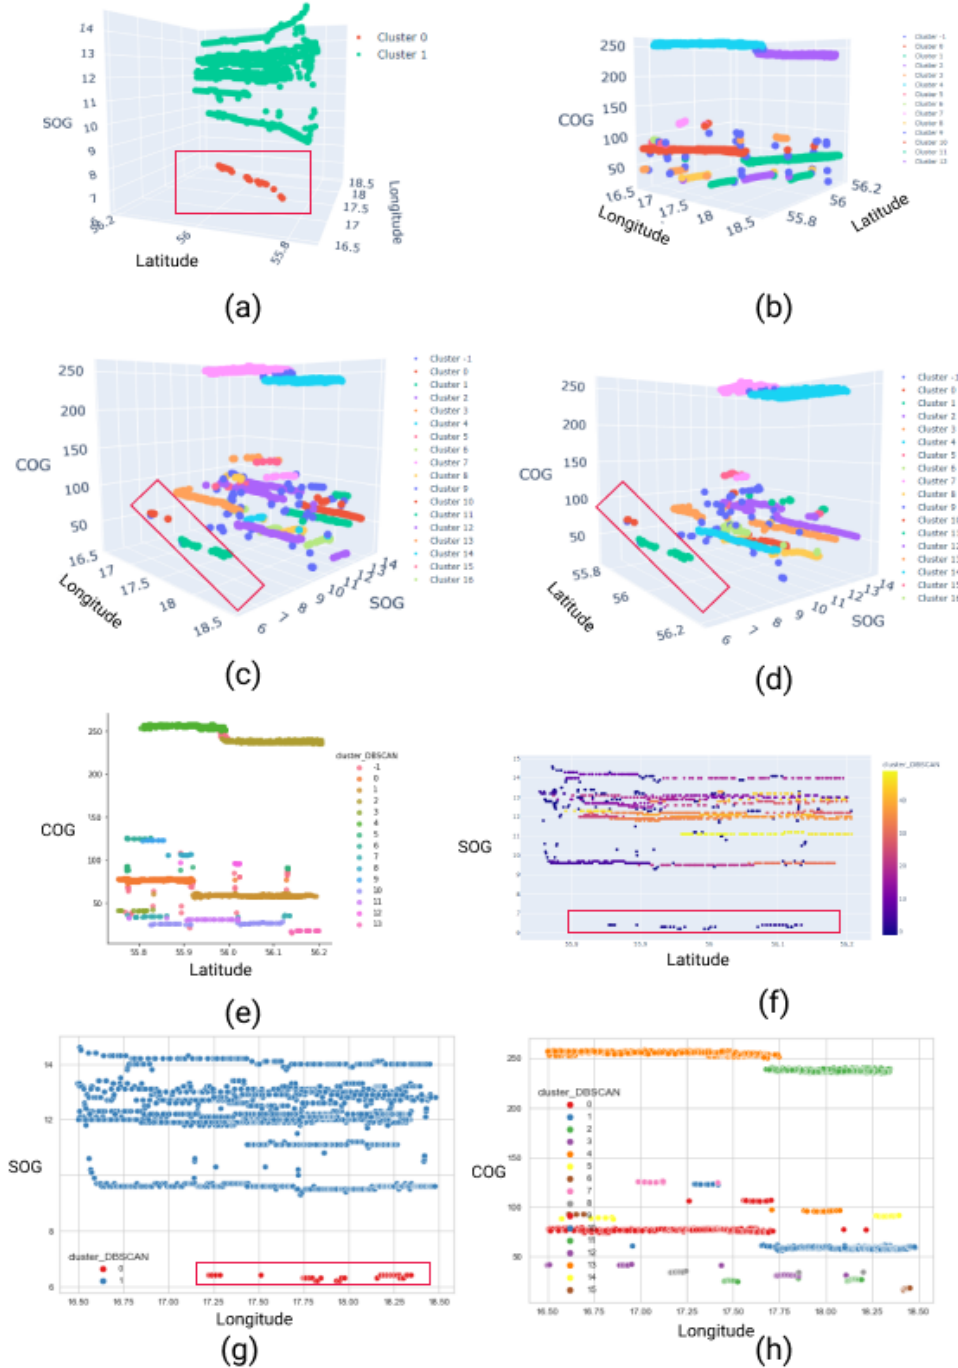
Figure 22. DBSCAN clustering results based on the two and three-dimensional inputs ( a – h